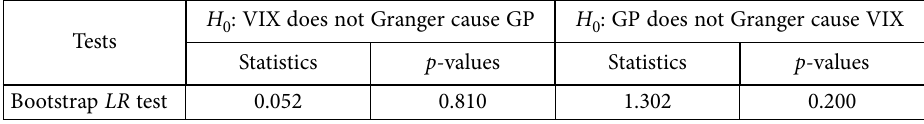
Table 2. Full-sample Granger causality